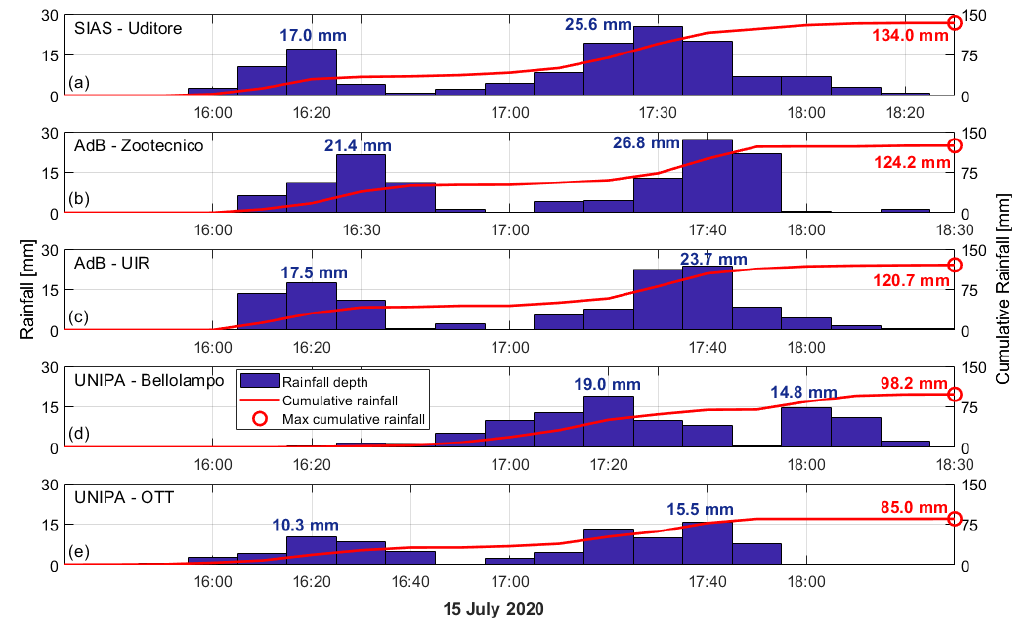
Figure 7. Rainfall collected at the rain gauges at (a) Uditore, (b) Zootecnico, (c) UIR, (d) Bellolampo, and (e) OTT on 15 July 2020 between 15:30 and